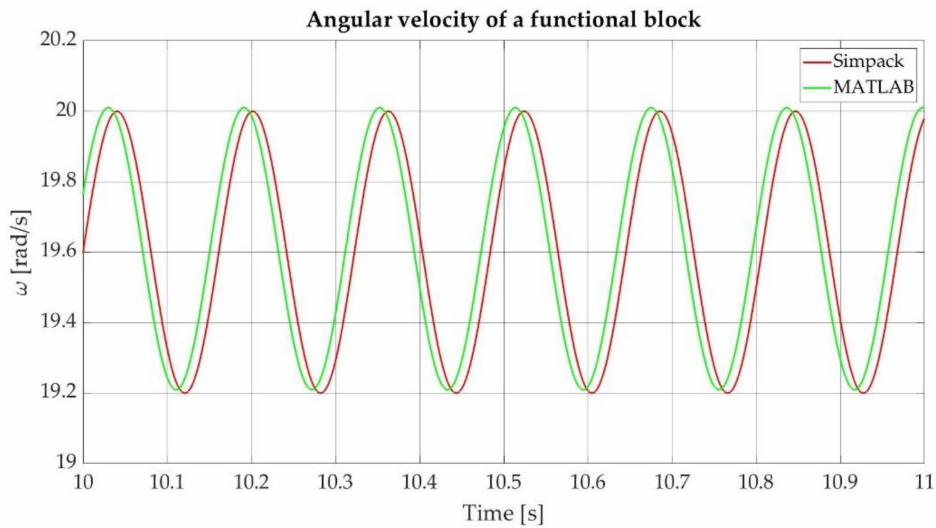
Figure 9. Angular velocity of a functional block—a comparison between the results from Simpack and MATLAB.